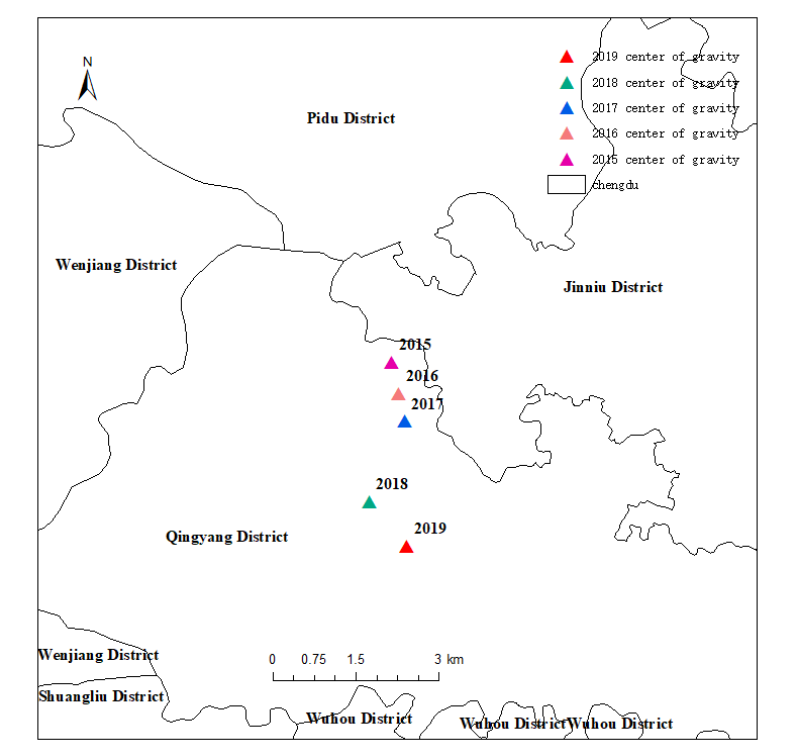
Figure 8. Center of gravity of urban built-up area in